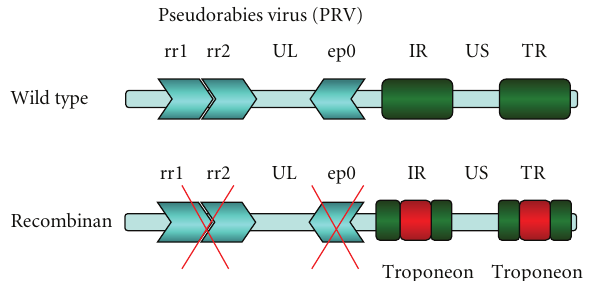
Figure 1: This panel shows a part of recombinant herpesvirus genome. To adapt for applicability as virus vector we deleted the two ribonucleotide reductase (rr) and the early protein (ep0) genes from the virus genome by homologue recombination. The rr1 and rr2 genes are in charge for production of raw material of viral DNA. The recombinant virus is not able to productively infect postmitotic cells without rr genes, while ep0 gene is responsible for virus reactivation from latency. Troponeon calcium sensor gene was inserted into the antisense promoter region in two